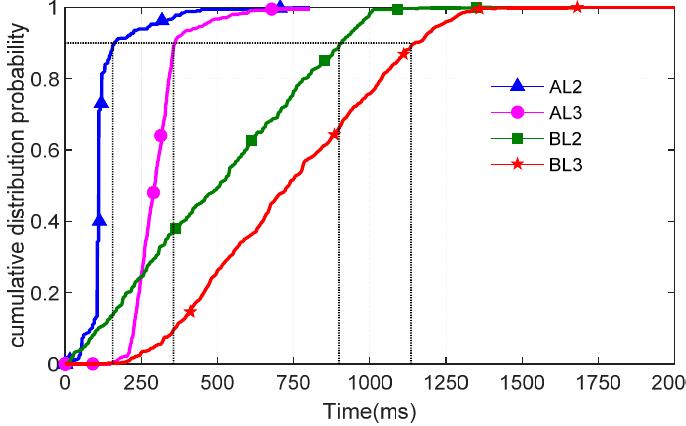
Figure 7. Failure recovery time of CDF (Cumulative Distribution Function).